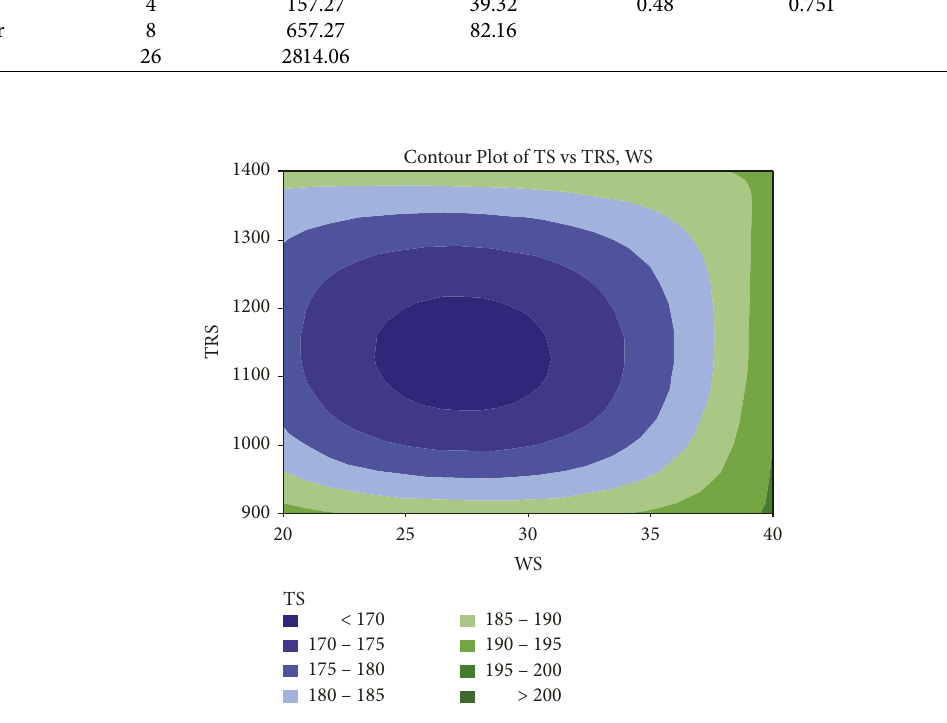
Figure 14: Contour plot TS vs TRS and